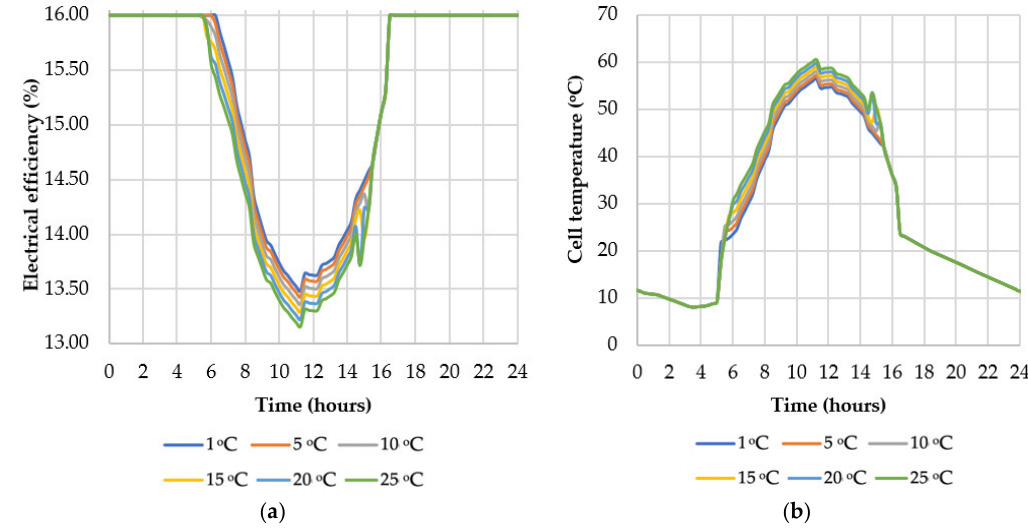
Figure 9. The variation of the ( a ) electrical efficiency; ( b ) cell temperature; during a typical summer day in Bucharest, Romania.